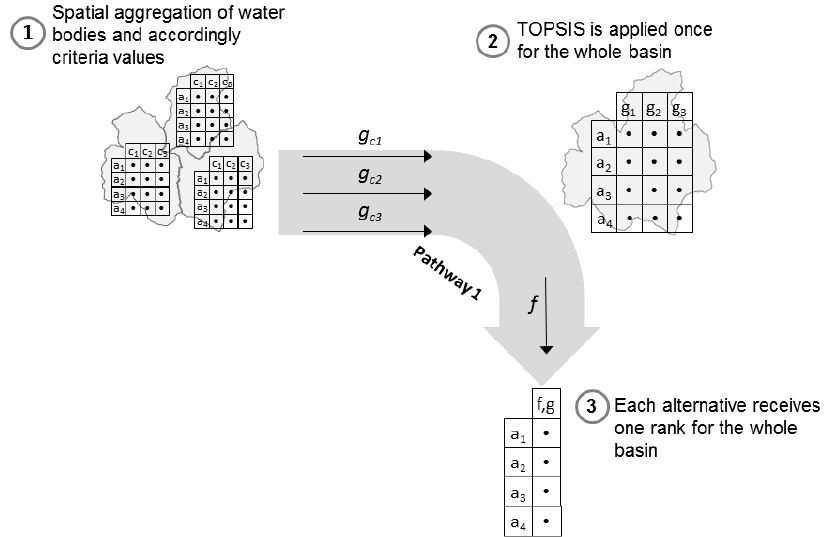
Figure 4. Methodology for pathway (1) considering the basin spatial scale, where we perform spatial aggregation (and accordingly criteria aggregation) as a first step, and subsequently apply TOPSIS to the entire basin.